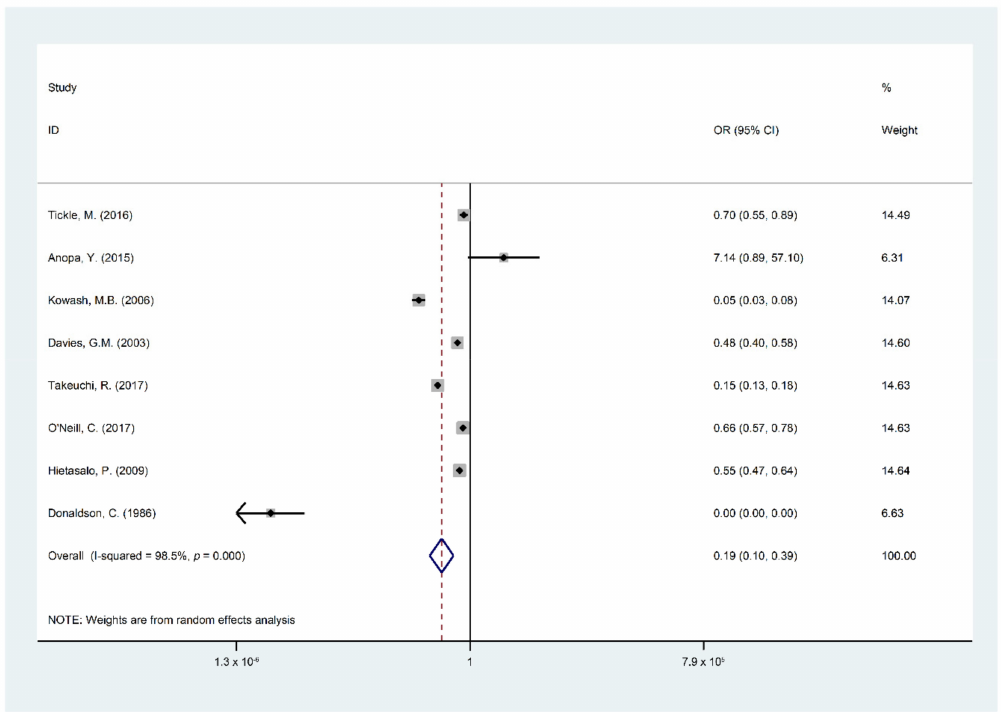
Figure 2. Forest plots of Decayed Missing Filled Teeth (DMFT) / S by the participating children.